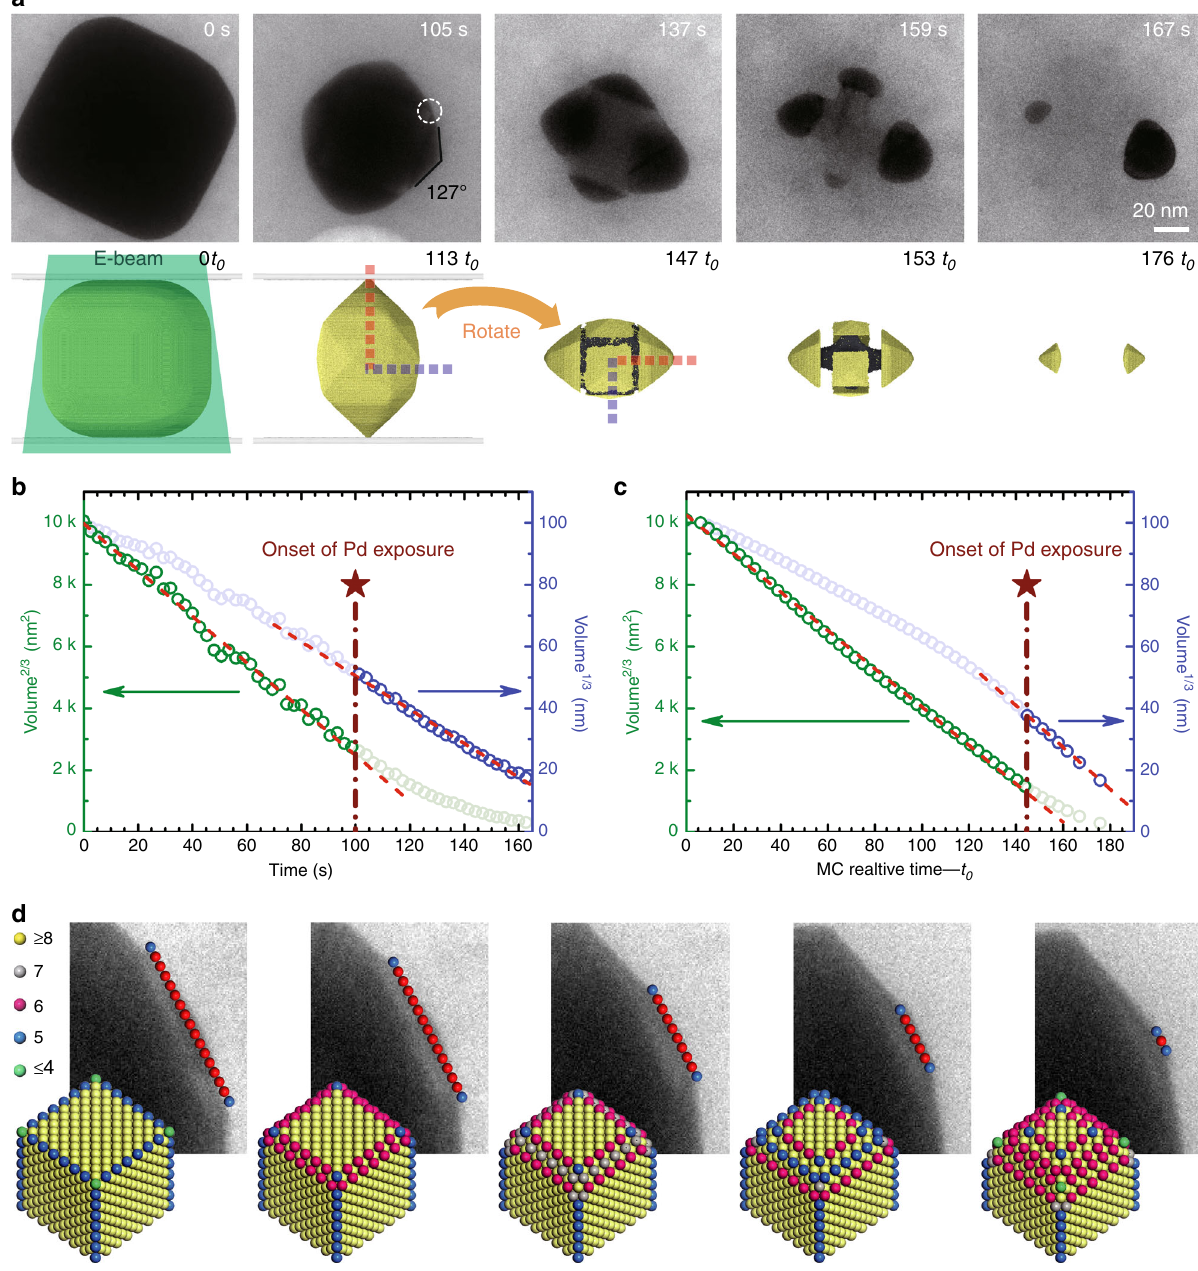
Fig. 3 Dissolution kinetics and reaction pathway of a Pd@Au nanocube inside a GLC. a Time-lapse TEM images and corresponding simulation snapshots extracted from Supplementary Movies 2a and 4 showing slow dissolution of nanocubes (44-nm Pd core and 35-nm Au shell) when exposed to a weakly oxidative environment. Chemical potential in simulation: − 3.525 eV. b , c Au-shell volume to the power of 1/3 and 2/3 as a function of time based on data from experiment b and simulation c . d Top: Time-lapse TEM images extracted from Supplementary Movie 3 showing the step recession process responsible for the evolution of pyramidal feature from an initially fl at (100) facet of the Au shell. Bottom: Atomistic models for a Pd@Au nanocube undergoing oxidative dissolution. Individual atoms are color-coded according to coordination number with color-coded legends shown at top